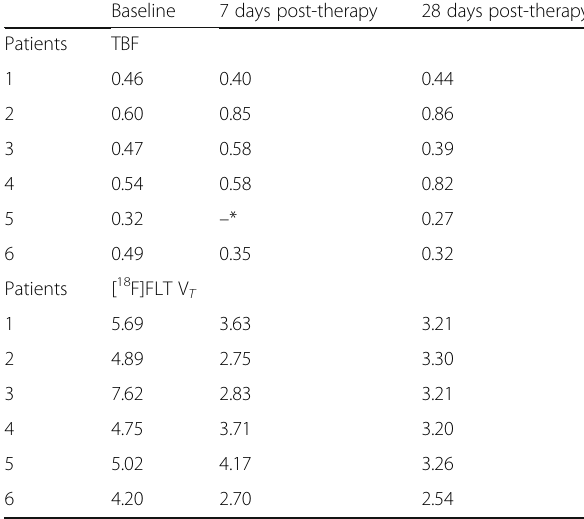
Table 3 Average TBF and [ 18 F]FLT V T values of all the lesions as assessed at the three time points: baseline, 7 days post-therapy and 28 days